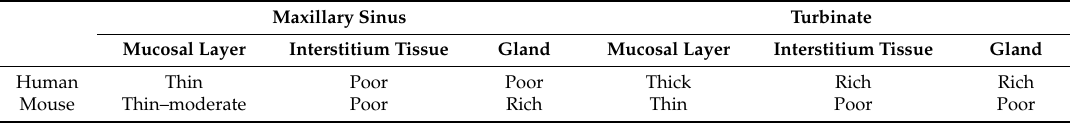
Figure 5. Histology of normal human paranasal sinus ( A ), normal mouse paranasal sinus ( B ), and nasal polyps from chronic rhinosinusitis with nasal polyps (CRSwNP) ( C ). Histological sections were stained using H&E. Table 1. Characteristics of human and mouse paranasal